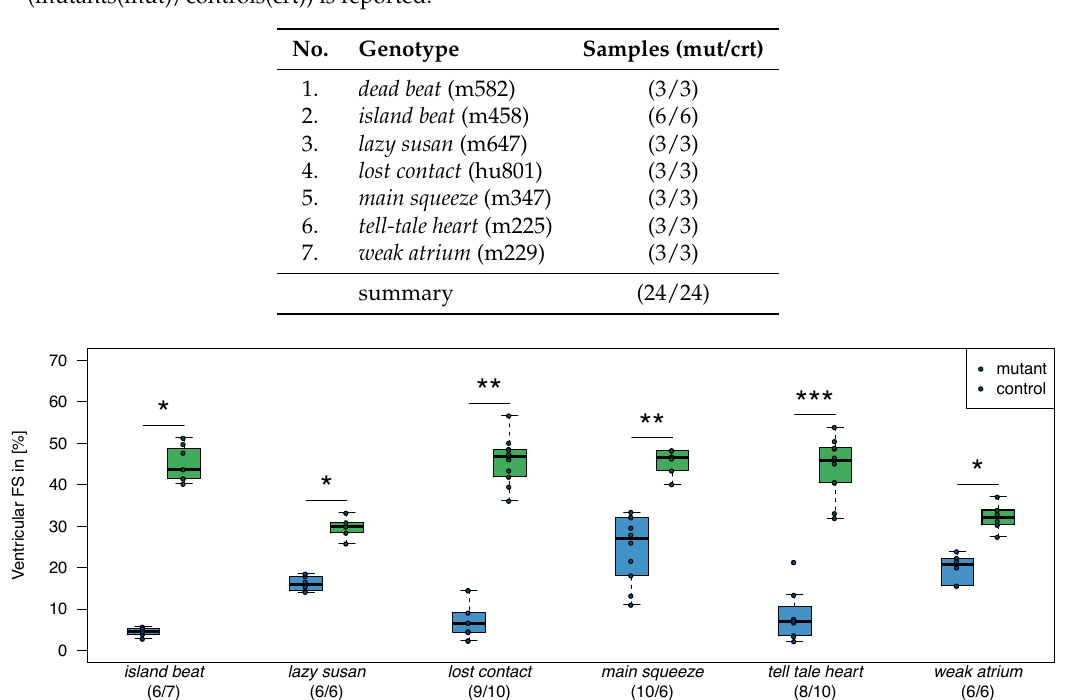
Table 2. Overview of the analyzed dataset: The dataset comprises gene expression profiles of 48 whole-fish samples seven individual genotypes (rows) with a weak contractility. The genotypes are named according to their observable heartbeat. For each genotype, the number of samples (mutants(mut)/controls(crt)) is reported.